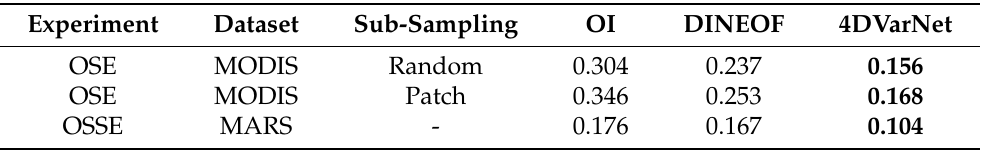
Table 2. RMSLE performance in log 10 [mg/L] for the considered methods and validation configu- rations. OSE refers to the real data (MODIS) interpolating process. The sub-sampling strategy is described in Section 3.2. OSSE dataset refers to the previous work [19] based on the MARS